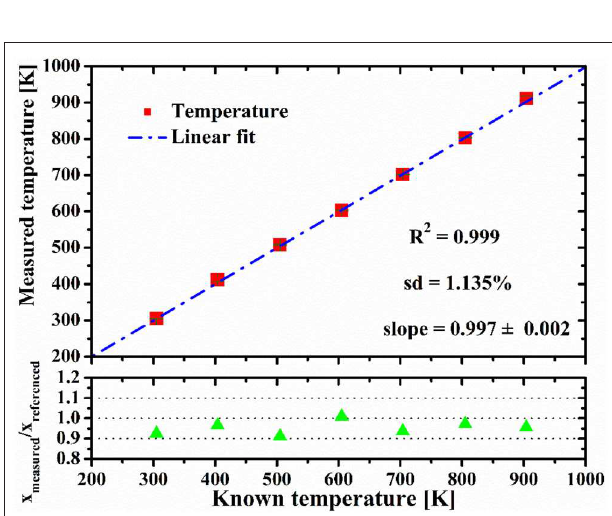
FIGURE 5 | Comparison between the measured temperature and the average of reading of three thermocouples (top row); ratio of the measured C 2 H 4 concentrations (X measured. ) and the concentrations recorded during gas premixing (X referenced. ) (bottom